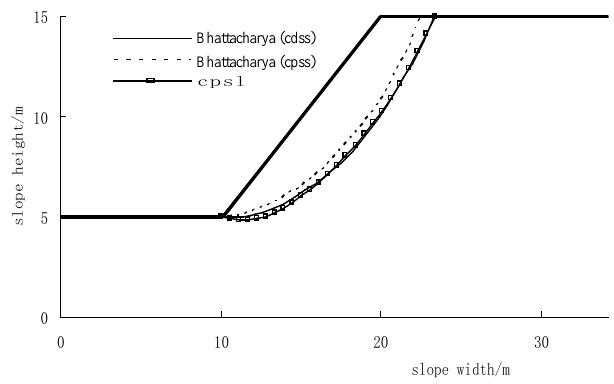
Figure 11. Summary of critical slip surfaces for example 1.